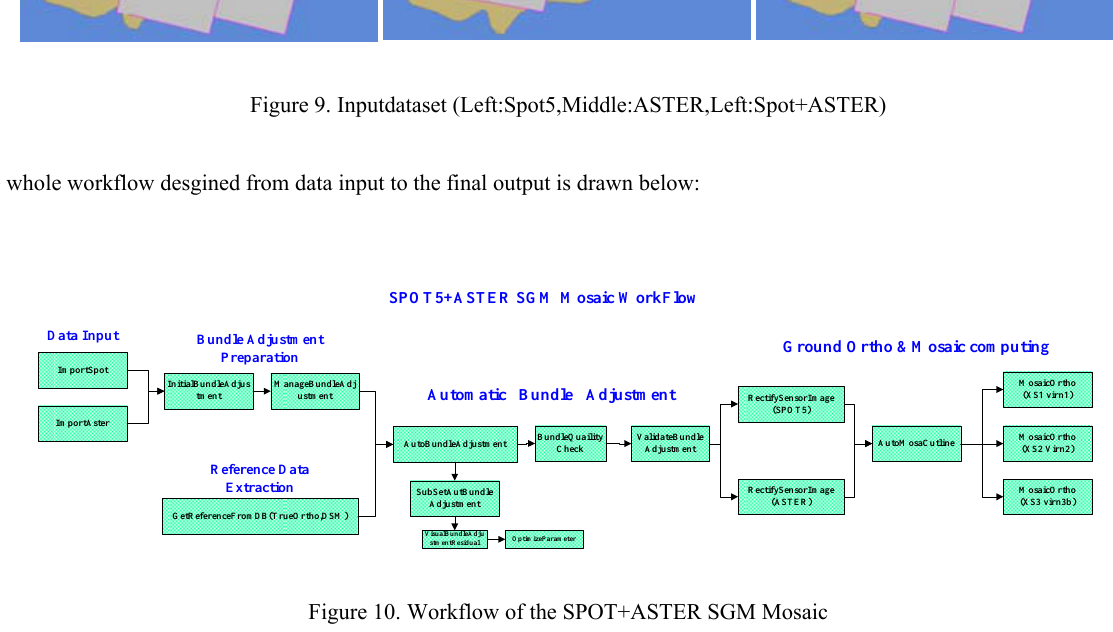
Figure 10. Workflow of the SPOT+ASTER SGM Mosaic